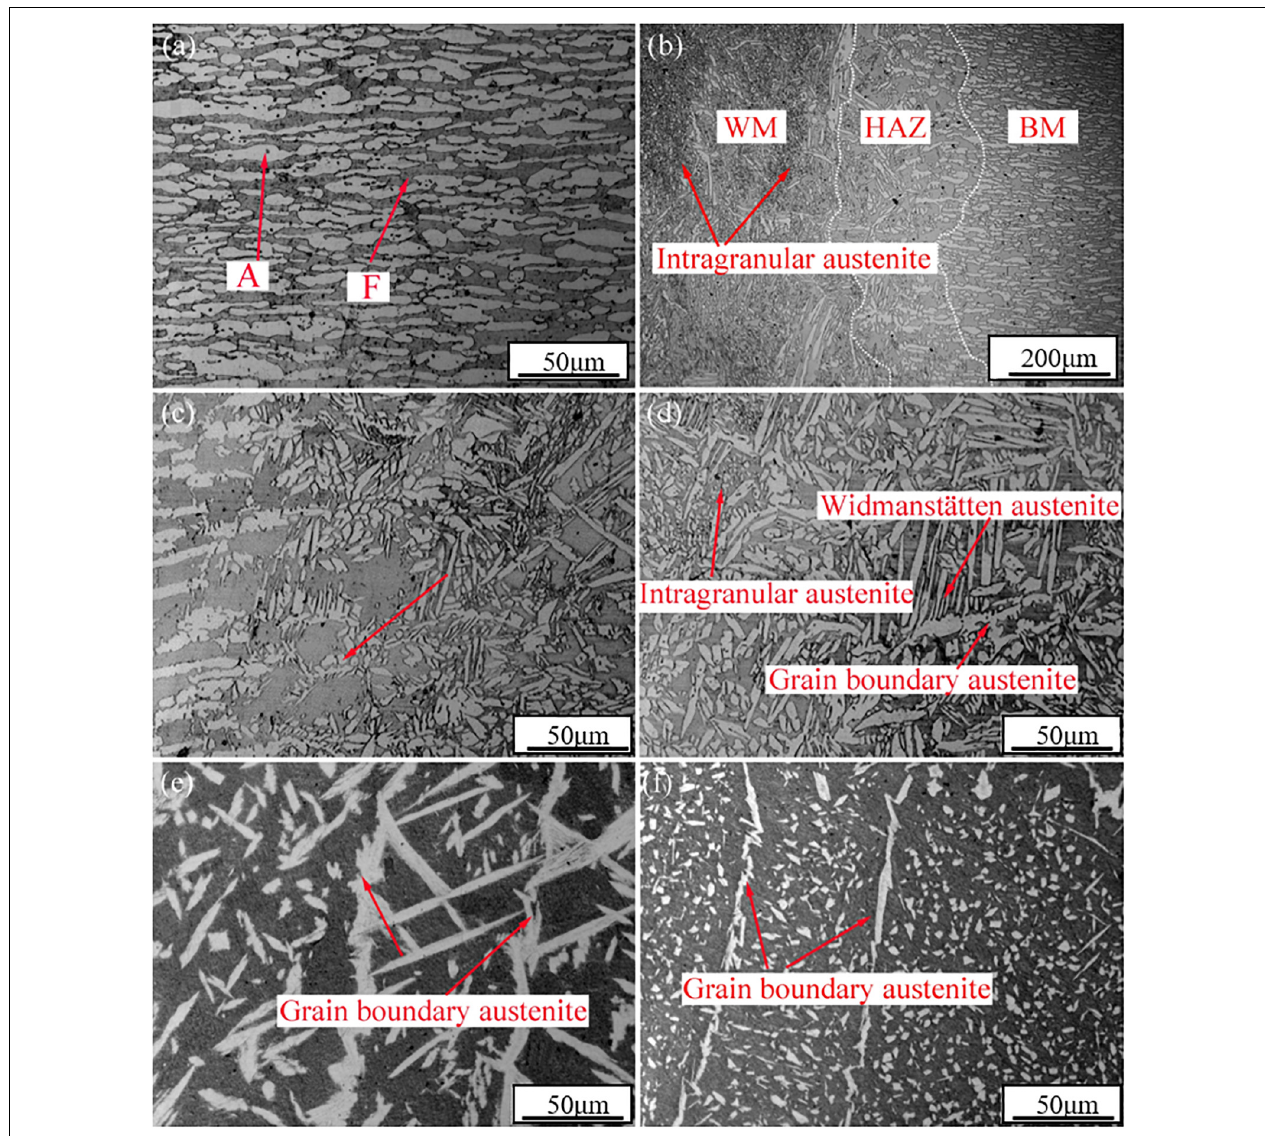
FIGURE 2 | The optical microstructures in different zones of the joint welded by GTAW: (a) the base metal; (b) the joint; (c) the heat-affect zone; (d) the weld center; (e) the weld cap; (f) the weld